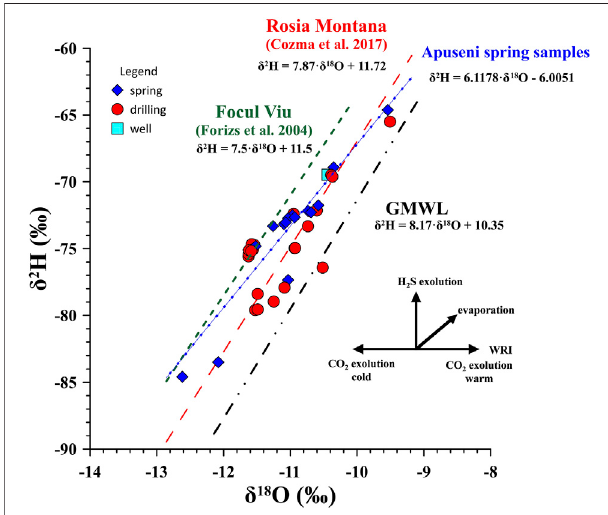
FIGURE 3 | Water stable isotope composition of the sampled sources. Symbols as in Figure 2